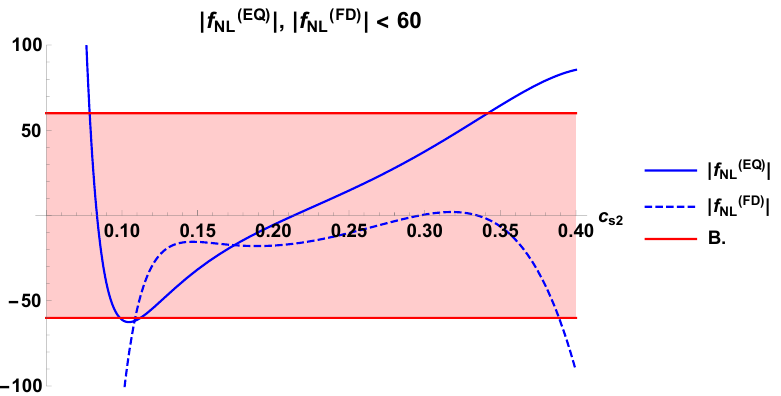
Figure 4 . Plot of the total equilateral and folded f NL with λ 9 = 0 . 05 . The red zone is the region | f NL | < 60 , considering the constraints f (EQ)